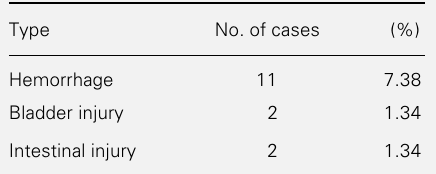
Table 2 - Intraoperative complications of radical hysterectomy patients.